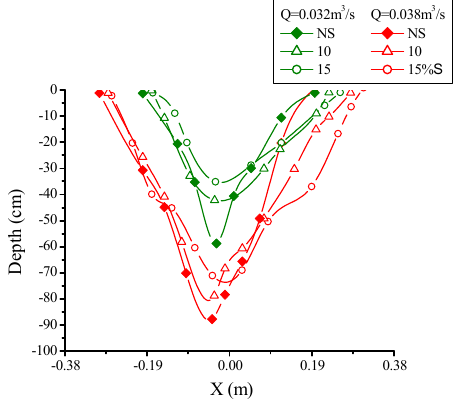
Figure 6. Longitudinal bed profile along the centerline.